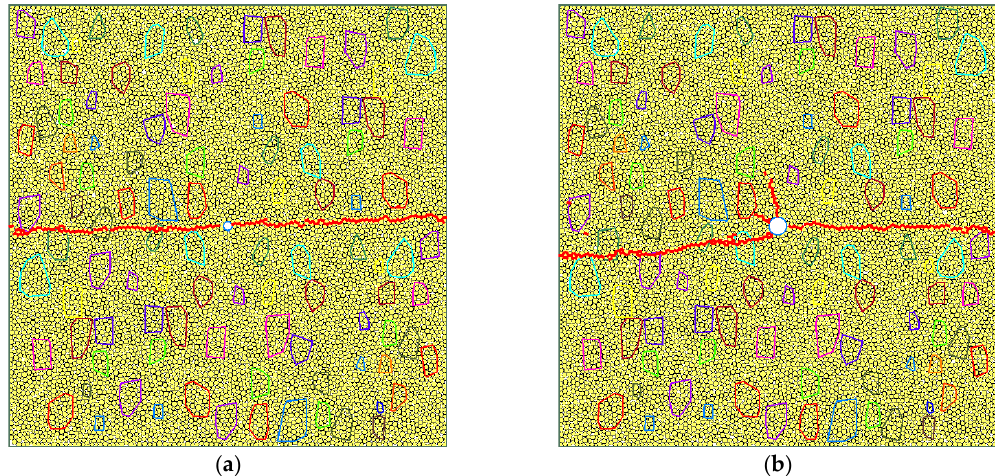
Figure 9. The fracture morphologies under different radii of the wellbore. ( a ) r w = 2 mm. ( b ) r w = 4